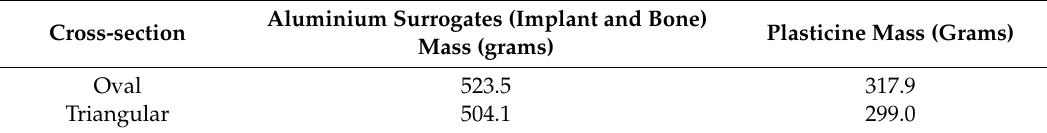
Figure 5. Images of the specimen with adhesive epoxy and plasticine: ( a ) Aluminium surrogate implant snug-fit with aluminium surrogate bone cylinder; ( b ) Specimen with adhesive applied between the aluminium surrogate implant and bone; ( c ) Specimen partially covered with plasticine prior to the experiment and ( d ) Specimen fully covered with plasticine. Table 1. Oval and triangular cross-section specimens’